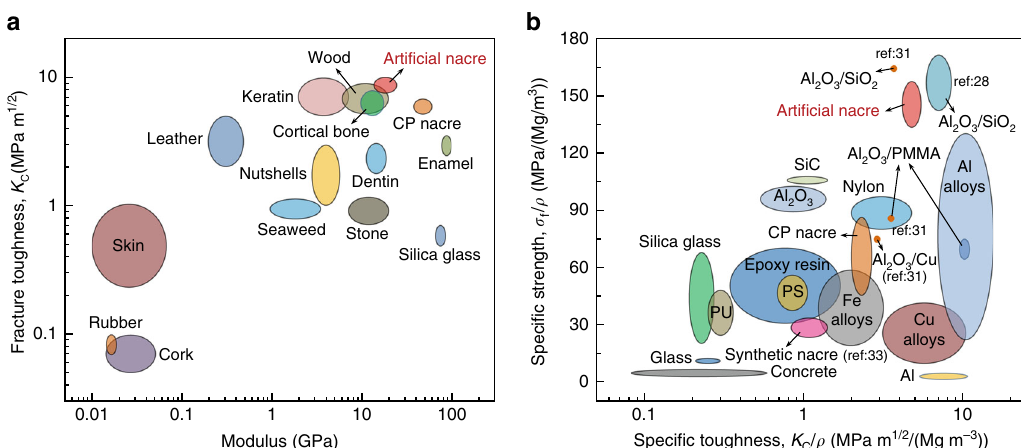
Fig. 4 Comparison of mechanical properties of our arti fi cial nacre with its competitors. a Ashby diagram of the fracture toughness of our bulk nacre-mimics compared with a wide range of natural structural materials as a function of their stiffness 49, 50 . b Ashby diagram of speci fi c strength vs. speci fi c toughness for our bulk nacre-mimics compared with a range of synthetic engineering materials 8, 26, 27, 30, 32,